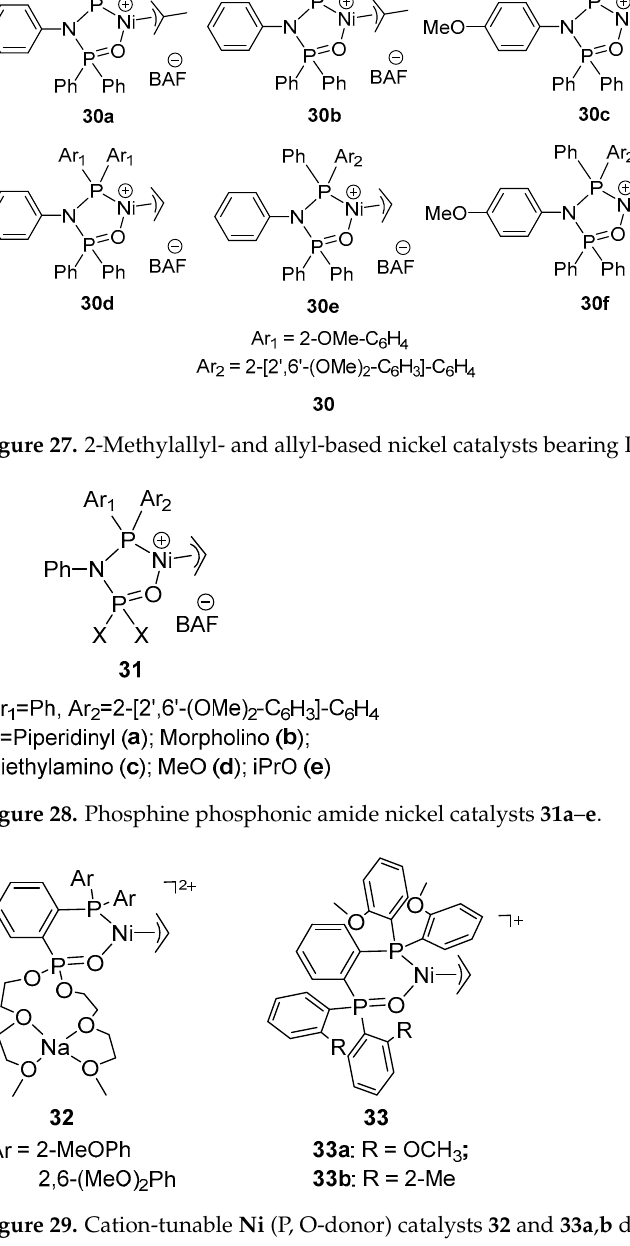
Figure 29. Cation-tunable Ni (P, O-donor) catalysts 32 and 33a , b developed in the Do laboratory.